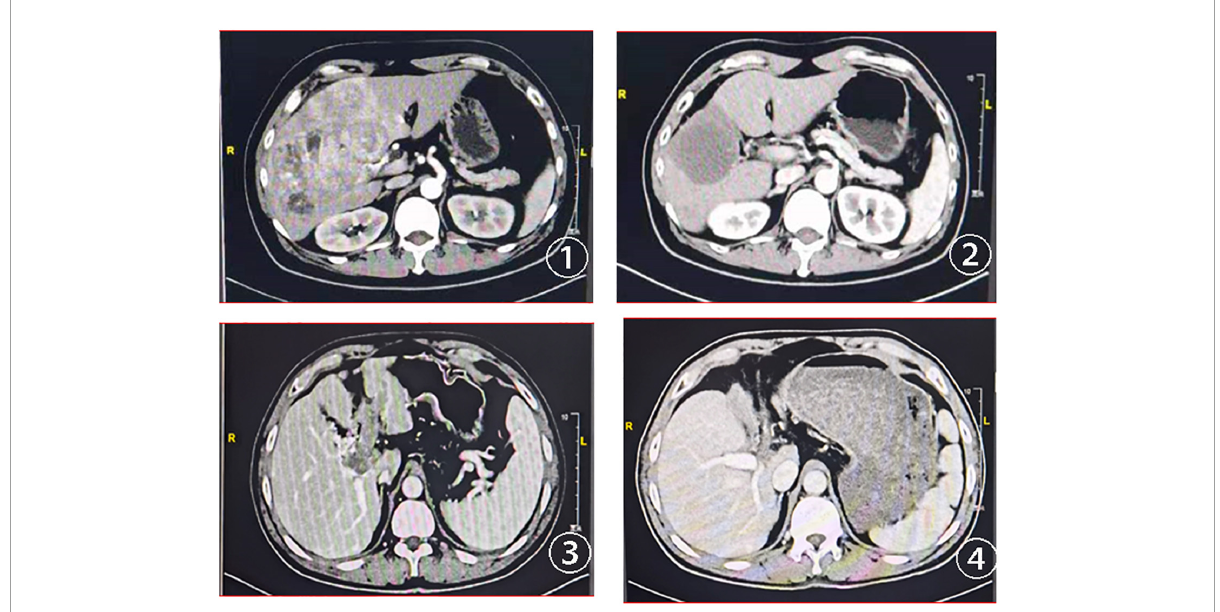
FIGURE3 CT scans at baseline and after treatment assessment for two advanced patients with HCC treated with HAIC combined lenvatinib and PD-1. (cid:192) Baseline CT scans of the first patient; (cid:193) CT scans of the first patient after two cycles of the combined treatment; (cid:194) baseline CT scans of the second patient with portal vein tumor thrombus; (cid:195) the portal vein tumor thrombus disappeared after the combined